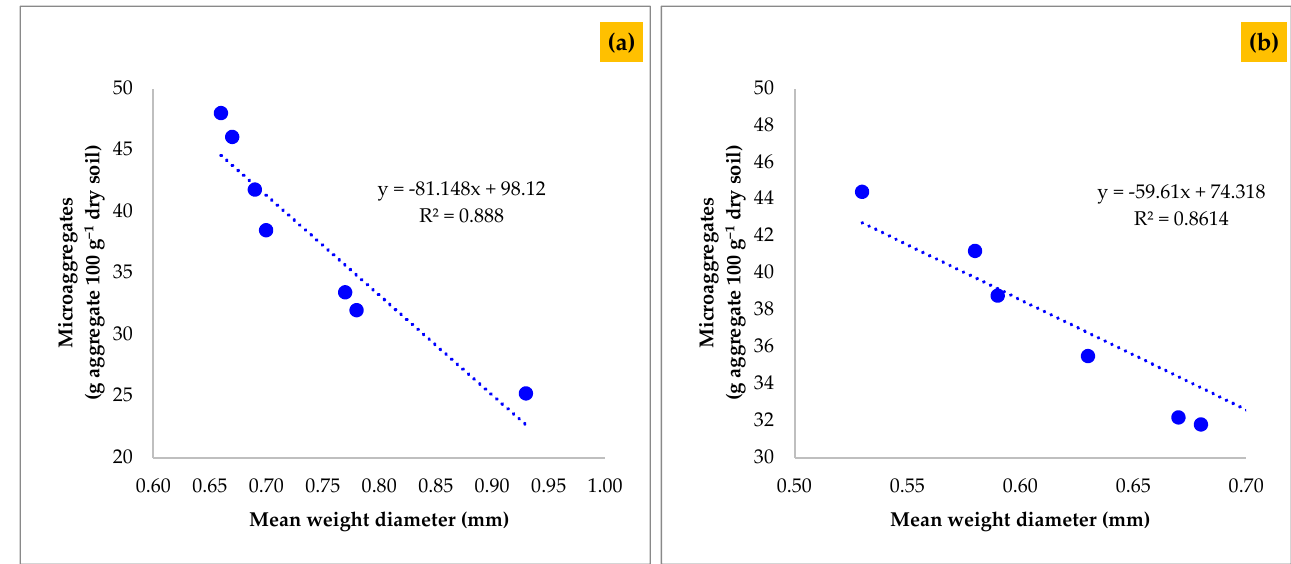
Figure 10. Relationship between microaggregate and mean weight diameter fractions of soil aggre- gation; ( a ) 0–15 cm and ( b ) 15–30 cm soil depths. The regression lines for microaggregate versus MWD showed a negative linear rela- tionship (microaggregate = − 81.148x + 98.12 and − 59.61x + 74.318) in the 0–15 and 15–30 cm soil depth (Figure 10a,b).